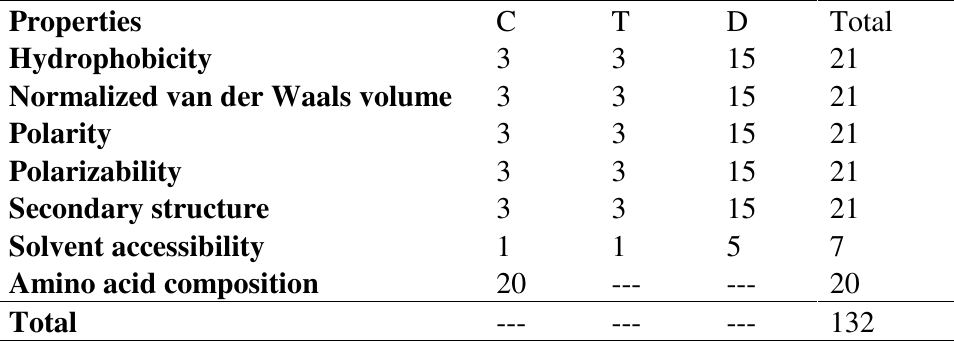
Table 1. Amount of properties in feature group 10–13.